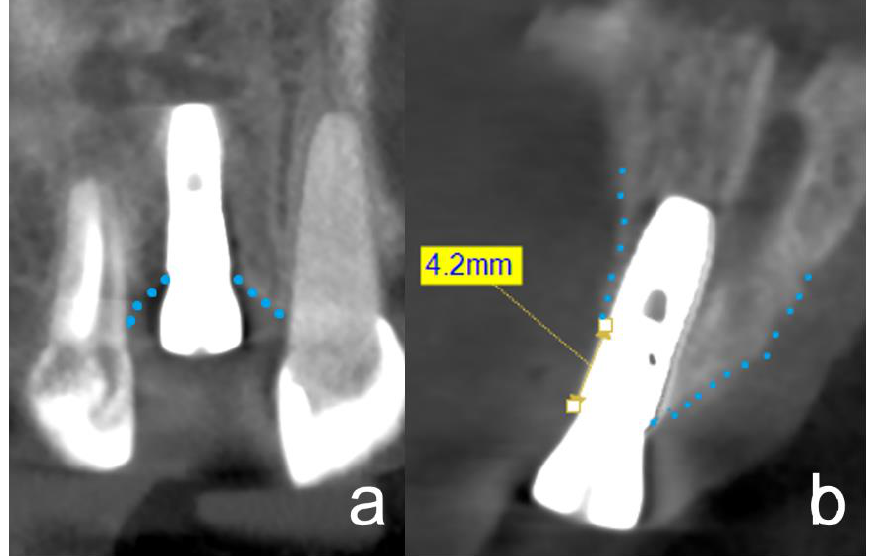
Figure 3. CBCT 3 months after implant insertion, at the time of implant exposure. The dotted lines outline the alveolar ridge. The images show distinct cases to demonstrate the respective measurement methods. ( a ): The frontal plane in the CBCT is equivalent to the two-dimensional X-ray image. At the time of implant exposure, there was no horizontal bone loss in either the mesial or distal area. ( b ): This figure is an example to show the measurement technique of resorption of the buccal lamella, if it was present at all. The measurements were taken from the implant shoulder to the first contact between the implant and the hard tissue. In this figure, an exemplary resorption of the buccal lamella of 4.2 mm can be seen.